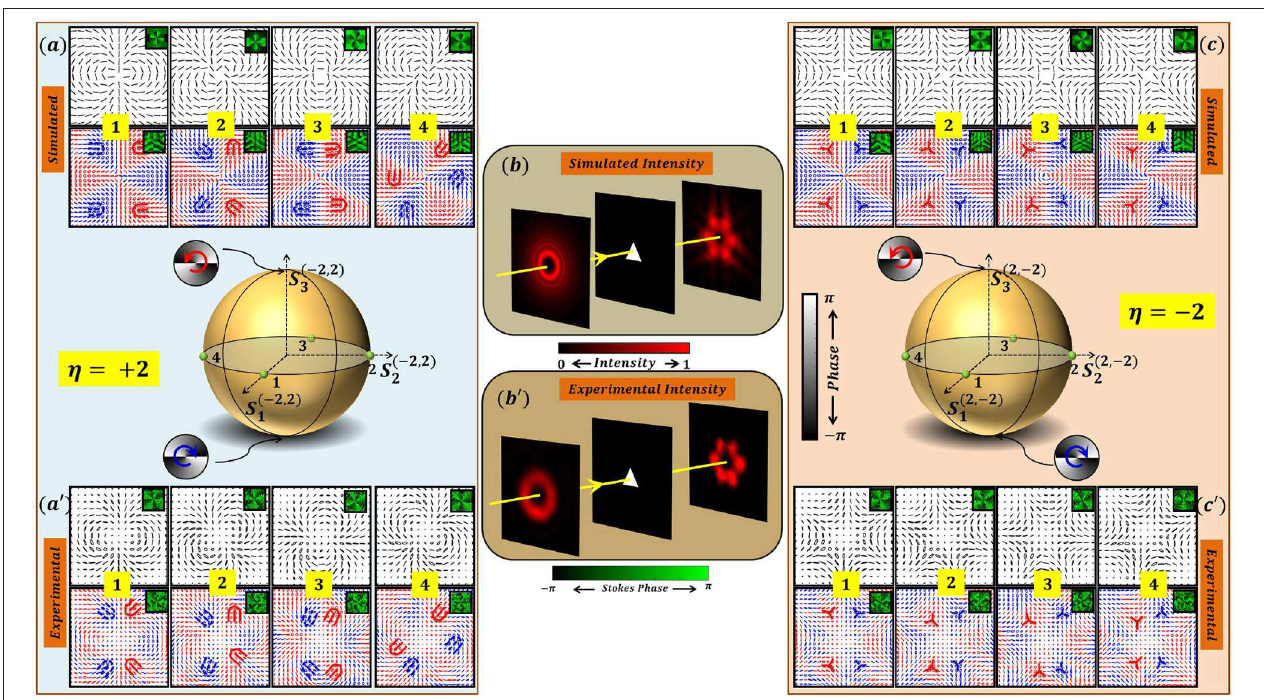
FIGURE 15 | Intensity degeneracy in the diffraction patterns of V-point beam with index | η | = 2 through a triangular aperture. Figures in left column: Input (first row) and diffraction (second row) field SOPs— (a) simulated and (a ′ ) experimental; Center column: (b) Simulated and (b ′ ) experimental schematic of the setup with input intensity, aperture, and diffracted intensity. Figures in the right column: Input (first row) and diffraction (second row) field SOPs—simulated (c) and experimental (c ′ ) ; In the center of the left and right column a HOPS is shown with numbers indicating the beams being diffracted, i.e., input